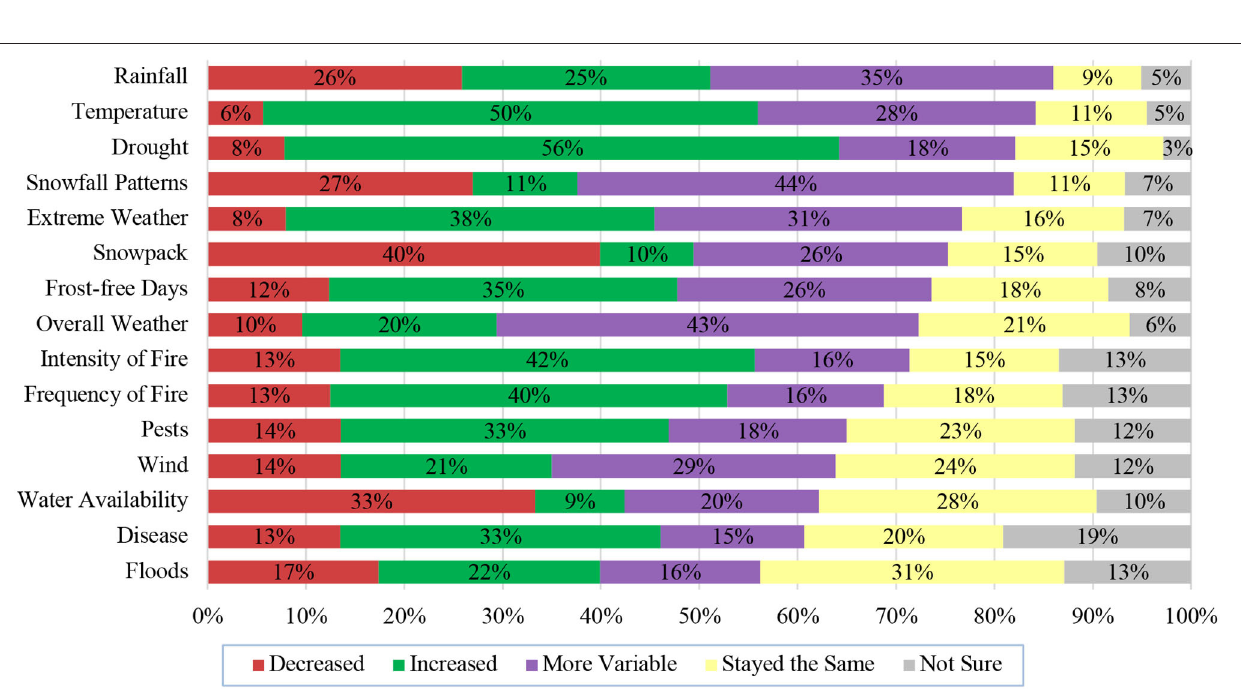
Frontiers in Sustainable Food Systems |